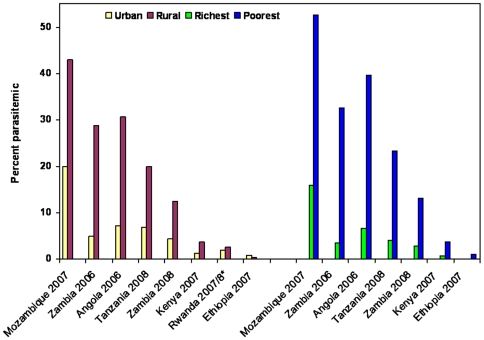
Malaria parasite prevalence in children.Percent parasitemia in children under-5 years of age by urban or rural setting and by richest or poorest wealth quintile, national Malaria Indicator Surveys in African countries. *The Rwanda DHS report did not include parasitemia comparisons by wealth quintile. All urban-rural and richest-poorest differences are statistically significant at P-value<0.001 except for Rwanda urban versus rural (X2 = 1.52, P-value = 0.2168). For Zambia, substantial increases in malaria intervention coverage occurred between the 2006 and 2008 surveys and likely accounts for the observed reduction in prevalence, predominantly in rural and poor populations.